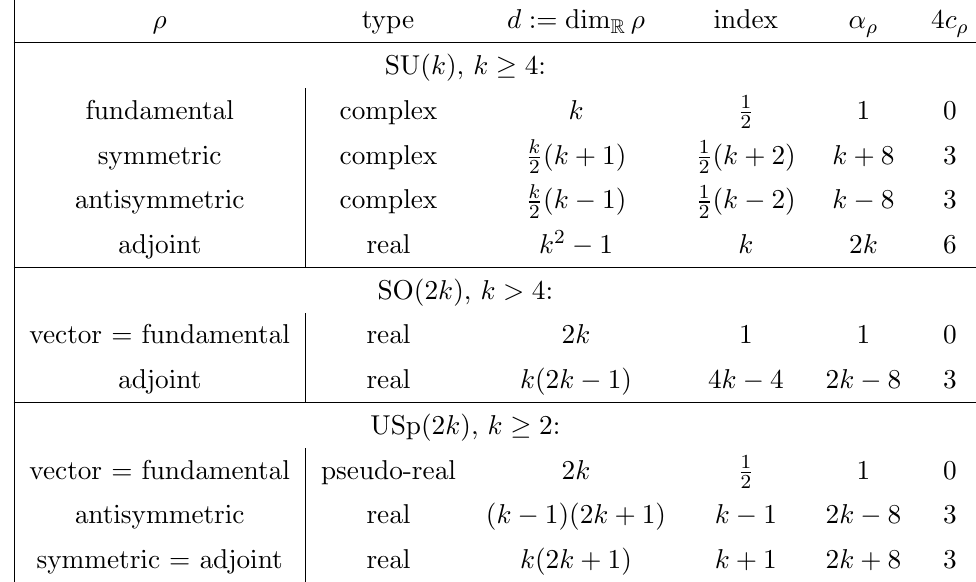
Table 4. The constants are taken from [73, 91] (with c there